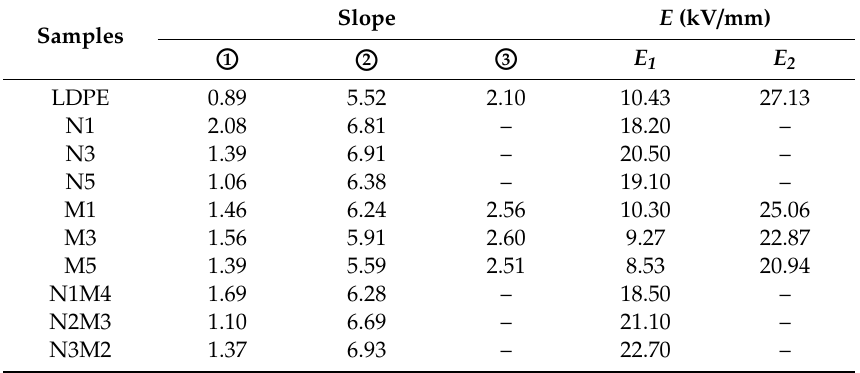
Table 2 lists the results. The slope value after fitting is in accordance with the space-charge limited current theory. The transition electric field threshold in the three areas were marked by E 1 and E 2 . Table 2. Slope and transition electric field characteristics of di ff erent